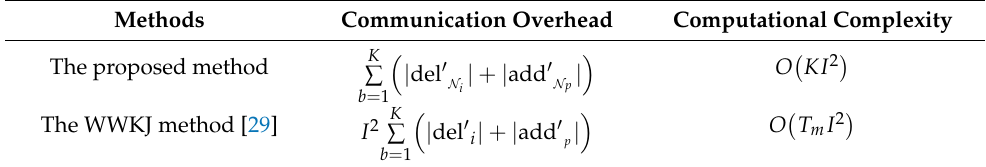
Table 1. The comparison of the communication overhead and computational complexity.